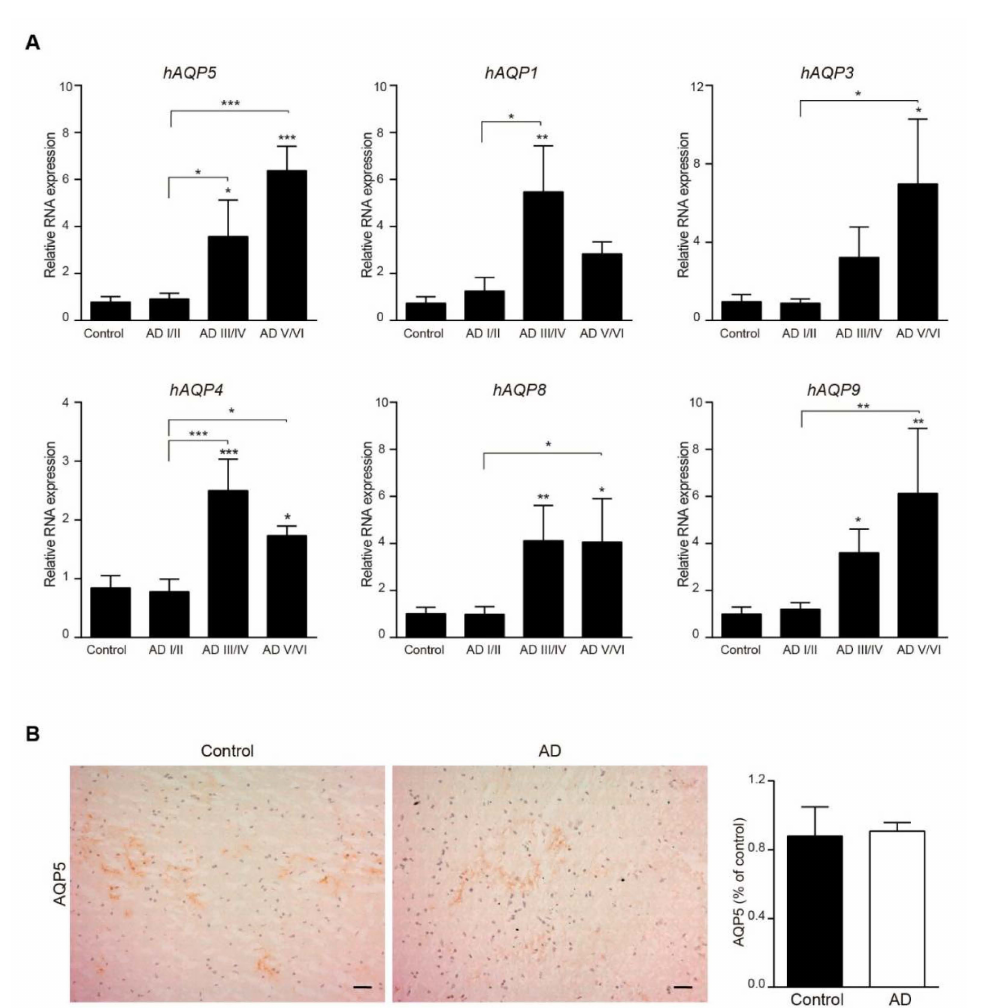
Figure 5. Expression of AQP5 in human cerebral cortex. Localization of AQP5 in cerebral cortex from AD and control post-mortem samples was detected by mRNA and immunostaining. ( A ) mRNA expression of human AQP5, 1, 3, 4, 8, and 9 in brain samples from AD and control patients (Table 2). ( B ) AQP5 stained sections of cerebral cortex from AD and control post-mortem samples. All sections were counterstained with hematoxylin. In the right histogram, quantification of the AQP5 signal ( n = 8, per group) is shown. Scale bar = 20 µ m. Data are represented as mean ± SEM. Differences between groups were assessed using the one-way ANOVA analysis followed by Dunnet correction. * p < 0.05, ** p < 0.01, *** p <